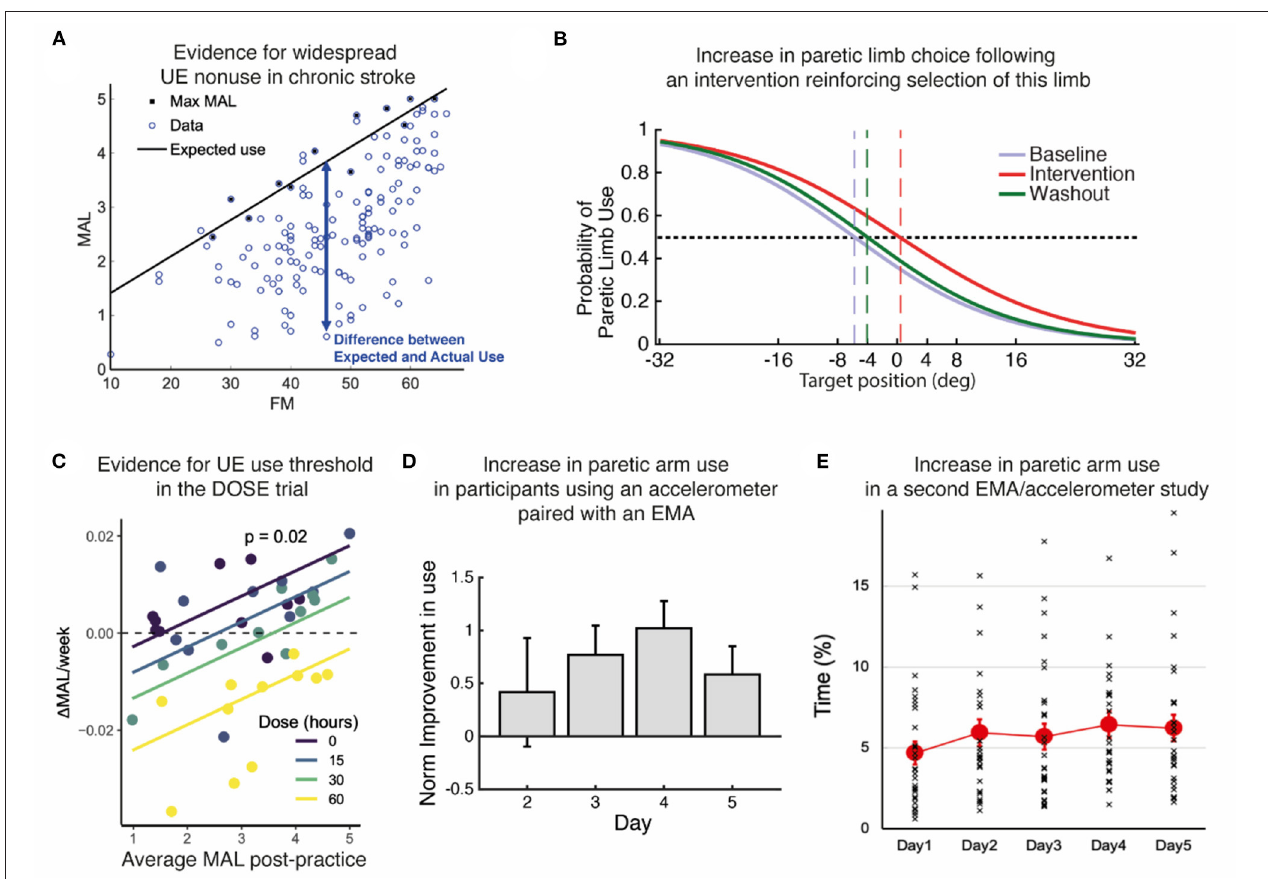
FIGURE 2 | Summary of evidence. (A) Re-analysis of baseline data from the EXCITE trial (24) shows prevalent UE non-use beyond what is expected from impairment levels. Motor Activity Log Amount of Use sub-scale (MAL) as a function of the Upper Extremity Fugl Meyer (FM). We estimated the maximal use MaxMAL given impairment by the maximum MAL in each bin of 2 FM points (black line: MaxMAL = 0.067 × FM + 0.74). (B) Increase in paretic arm choice following an intervention that focuses on reinforcing the selection of this limb ( 25). Logistic fit of all subject’s probabilities of paretic limb choice against target direction before (baseline), during, and after (washout) the intervention. Vertical dashed lines indicate targets with an equal probability of being reached with either arm. (C) Evidence for a threshold following practice in the DOSE study (26). The average weekly change in Motor Activity Log-Quality of Movement (MAL) following supervised practice is positively modulated by the average MAL post-practice for each dose. The intersections of the regression lines with the horizontal dashed line show the thresholds for each dose. Colored lines: retention rates as a function of average post-practice MAL for different doses; dots: individual retention rates. (D) Increase in paretic arm use in our first study using an accelerometer-embedded bracelet device paired with an EMA ( 25). Mean change in the activity of the paretic limb estimated by the wearable system across participants with respect to day 1 across days of intervention in which patients received haptic feedback and arm activity reports (days 2–4), and immediately after (day 5). (E) Small but statistically significant increase in paretic arm use over 5 days in our second study with an EMA / accelerometer combination (27). Solid color circles: daily average duration of unimanual right (paretic) arm/hand movements. Error bars, standard errors. Cross ( × ): individual use duration as a % of accelerometer wearing